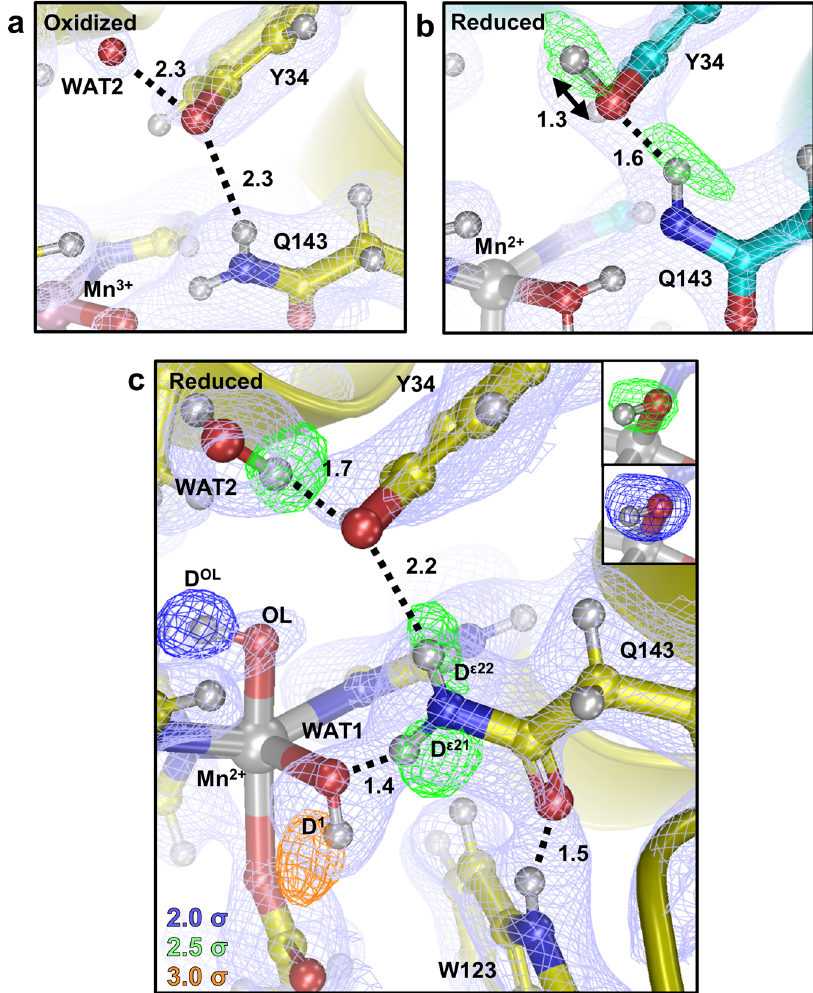
Fig. 4 Protonation and active site coordination of MnSOD. a , b Neutron structures of fi ve-coordinate Mn 3 + SOD and Mn 2 + SOD. Green omit | F o | − | F c | difference neutron scattering length density is at 3.0 σ . c The six-coordinate Mn 2 + SOD active site of Chain A with green omit | F o | − | F c | difference density displayed at 2.0 σ , 2.5 σ , and 3.0 σ for blue, green, and orange contours, respectively. | F o | − | F c | difference density is for individual D atoms except for the upper-right corner that is for both atoms of the anionic oxygen ligand (OL). Light blue 2| F o | − | F c | neutron scattering length density is displayed at 1.0 σ . Numbers are distances in Å. For the oxidized state, only one chain is shown due to high structural similarities, see Supplementary Fig. 2 for chain